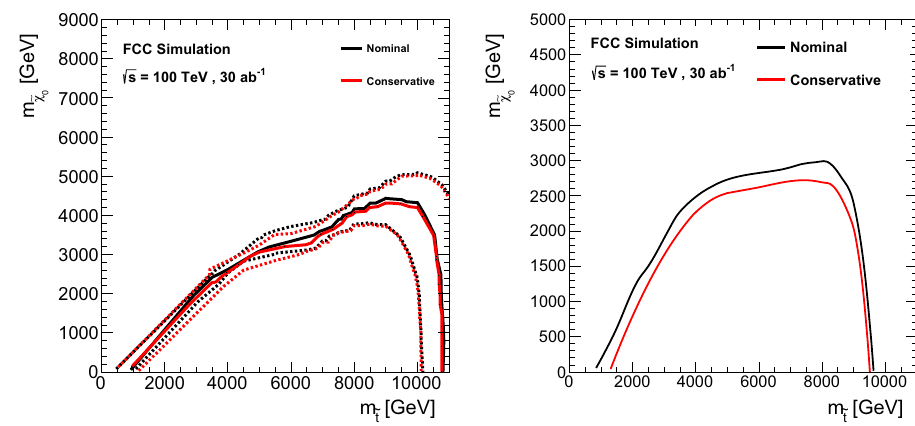
Fig. 9.2 Left: exclusion potential for stops at FCC-hh. The area below the solid red (black) curve represents the expected exclusion and the ± 1 σ contours for the nominal (conservative) scenario of associated systematic uncertainties. Right: 5 σ